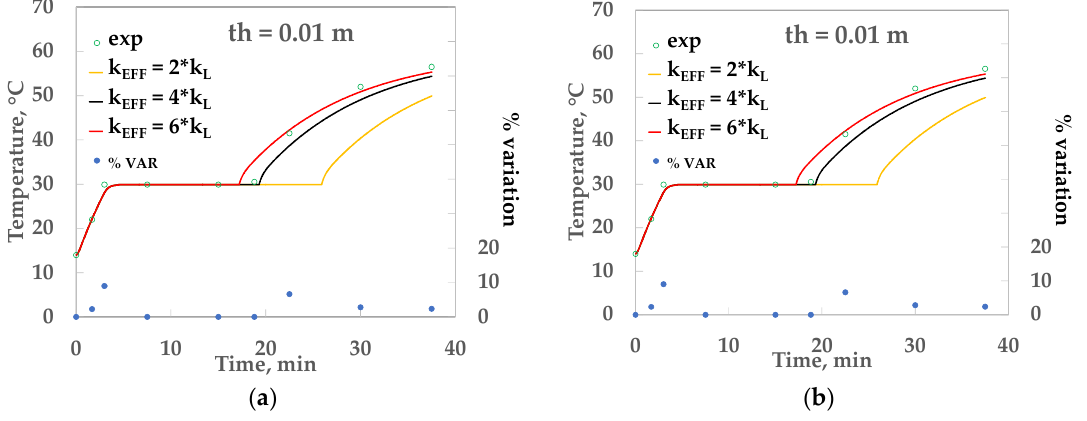
Figure 6. Validation of the mathematical model of a rectangular container at a PCM thickness of ( a ) 0.01 m and ( b ) 0.02 m.